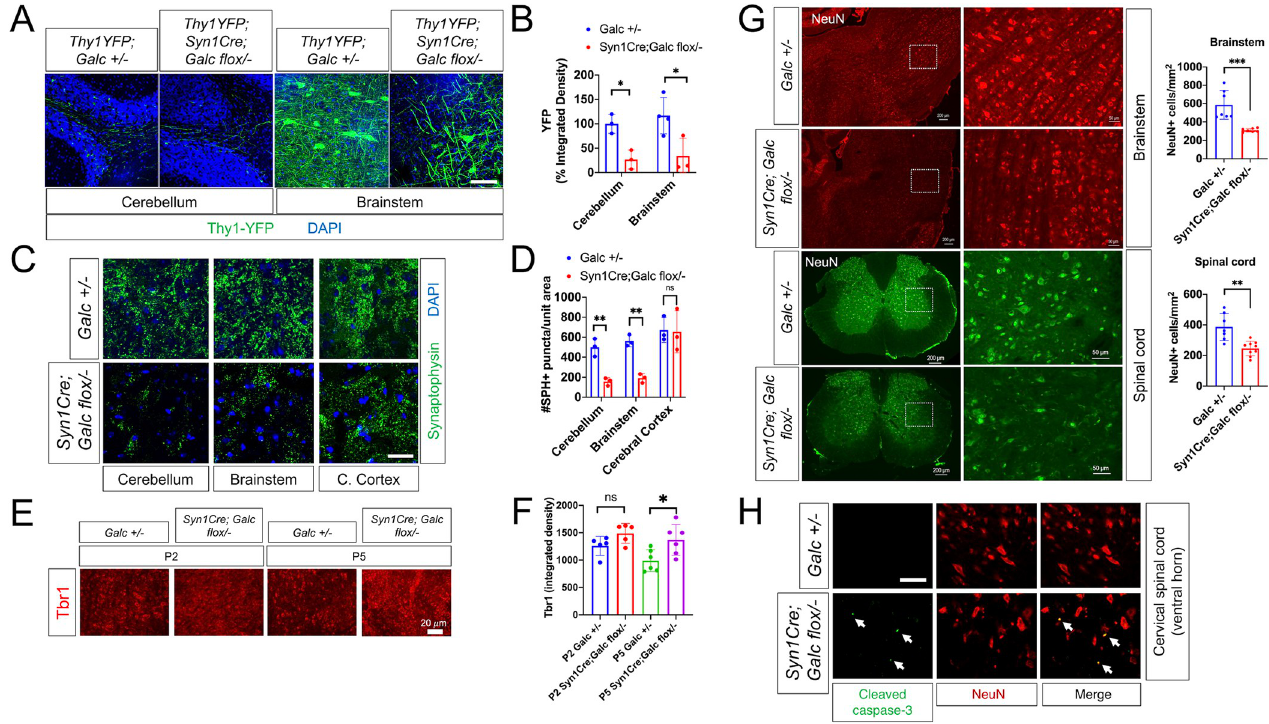
Fig 5. Neuronal complexity was greatly reduced by neuronal GALC depletion. ( A, B ) Double transgenic mice of 1-year-old Syn1Cre; Galc flox/−; Thy1.1-YFP shows that a decrease in the density of YFP neurons/axons in the brainstem and cerebellum, compared to control ( Galc +/−; Thy1.1-YFP). Scale bar = 50 μ m. ( C ) Puncta stained with SPH, a presynaptic marker, were counted by immunohistochemistry on brain sections of 6-month-old Syn1Cre; Galc flox/− . Scale bar = 50 μ m. ( D ) Quantification of the puncta of SPH shows that their level was dramatically reduced in the cerebellum and brainstem, but not in the cerebral cortex of Syn1Cre; Galc flox/− , N = 3 per genotype. All data are presented as mean values + /− SEM. Two-way ANOVA with Tukey multiple comparison tests were used. � P < 0.05, �� P < 0.01 and ��� P < 0.001. ns, not significant. ( E , F ) Immature neuronal marker, Tbr1 expression is significantly higher in the brainstem of Syn1Cre; Galc flox/− mice, compared to Galc +/− . ( G ) NeuN-positive neuronal cell bodies were significantly reduced in both brainstem and spinal cord regions of 1-year-old mutant mice. ( H ) Immunostaining of cleaved caspase-3 (green) and NeuN (red) revealed that neuronal cell death is increased in the ventral horn of spinal cord (white arrows) of 6-month-old Syn1Cre; Galc flox/− compared to control. Scale bar = 50 μ m. The underlying data for B , D , F , and G can be found in S1 Data. GALC, galactosylceramidase; SPH, Synaptophysin.